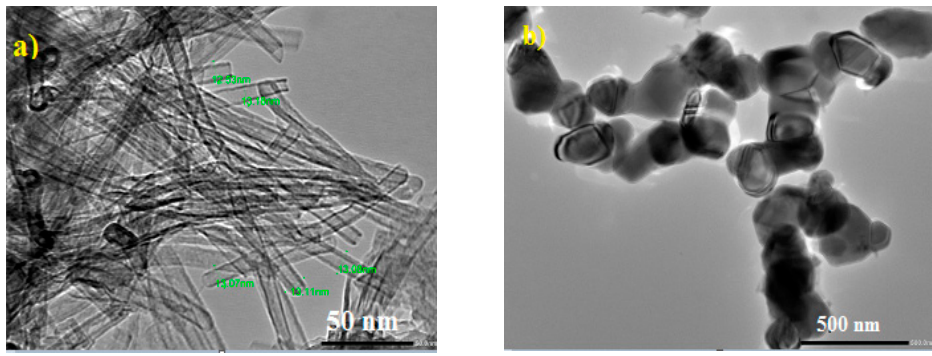
Figure 4. TEM images of ( a ) SO 4 -TiO 2 nanotubes and of ( b ) PO 4 -TiO 2 .